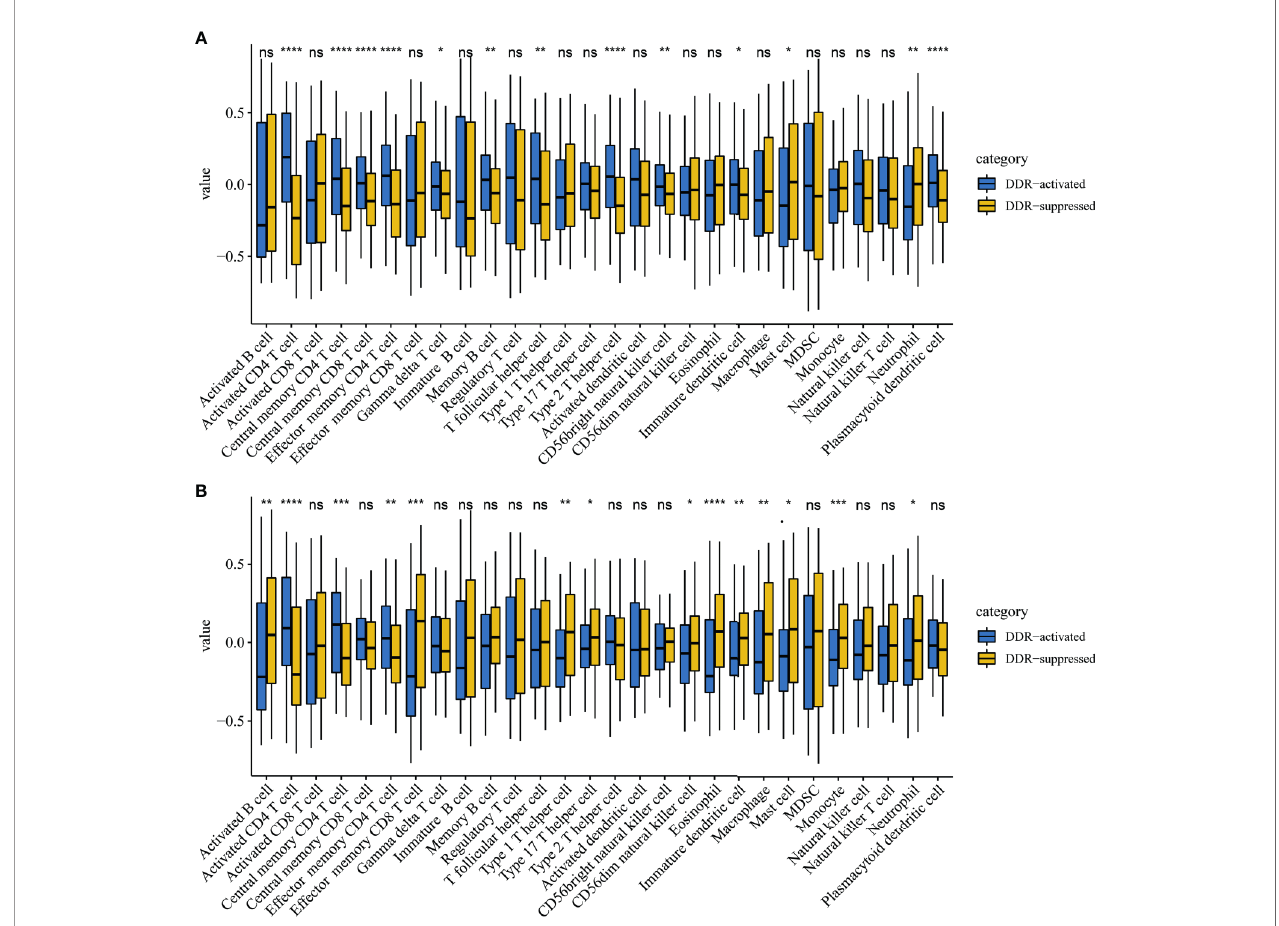
FIGURE 4 | Immune pro fi le alterations between the DDR-activated and DDR-suppressed subgroups. (A) TCGA; (B) ICGC. * represents P < 0.05, ** represents P < 0.01,*** represents P < 0.01, **** represents P < 0.0001, ns represents no signi fi cant